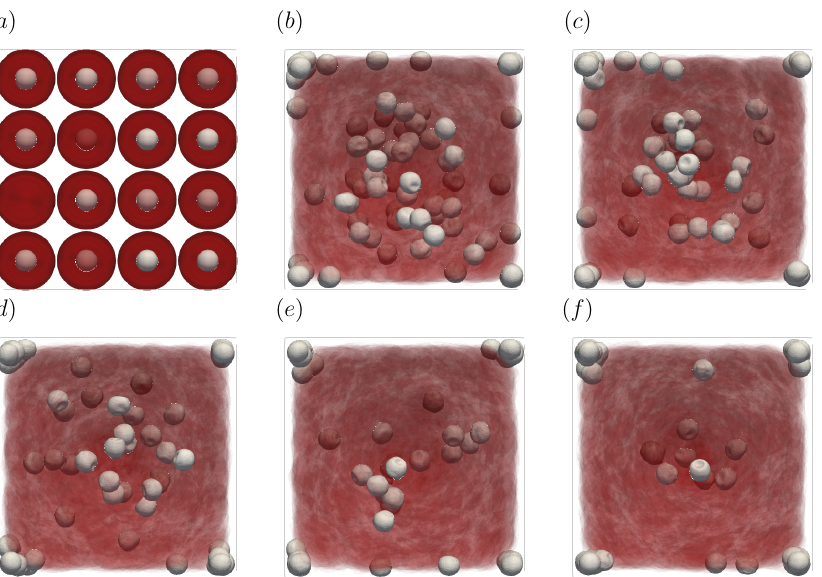
Figure 9. Snapshots of the simulation results in a straight channel of 224 × 32 × 32 µ m for ˙ γ w = 712 s − 1 , Ht = 40% at ( a ) t = 0, ( b ) t = 1.0, ( c ) t = 2.0, ( d ) t = 3.0, ( e ) t = 4.0, and ( f ) 5.0 s. The particles move gradually toward the corners of the